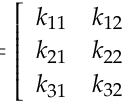
180 degrees, by multiplying gains k 11 and k 14 by − 1 for negative rotation speed values, restores angles